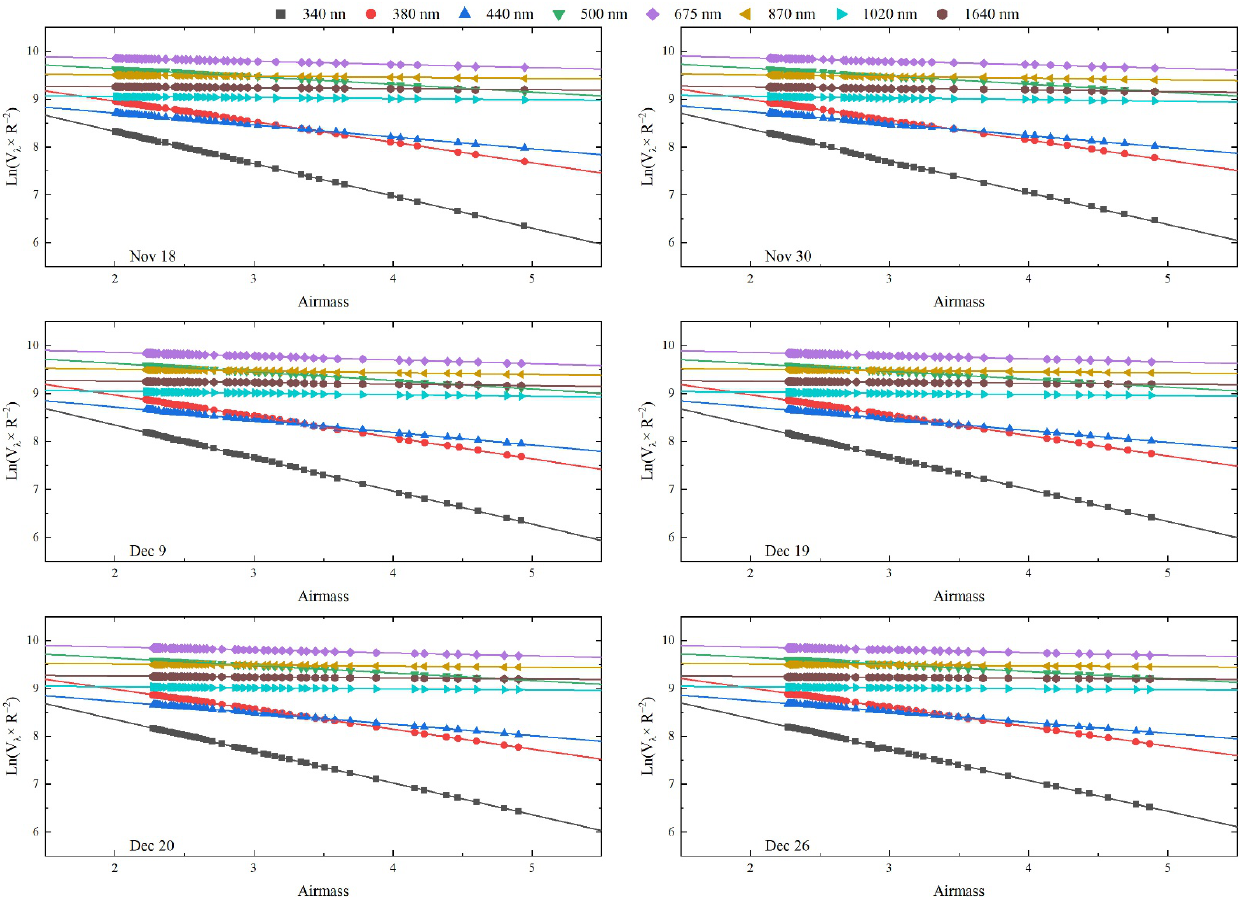
Figure 7. Langley plots acquired in the morning on the six study days. Table 3. Statistical analysis of the linear regression for Langley plots at the MFYD Observatory.